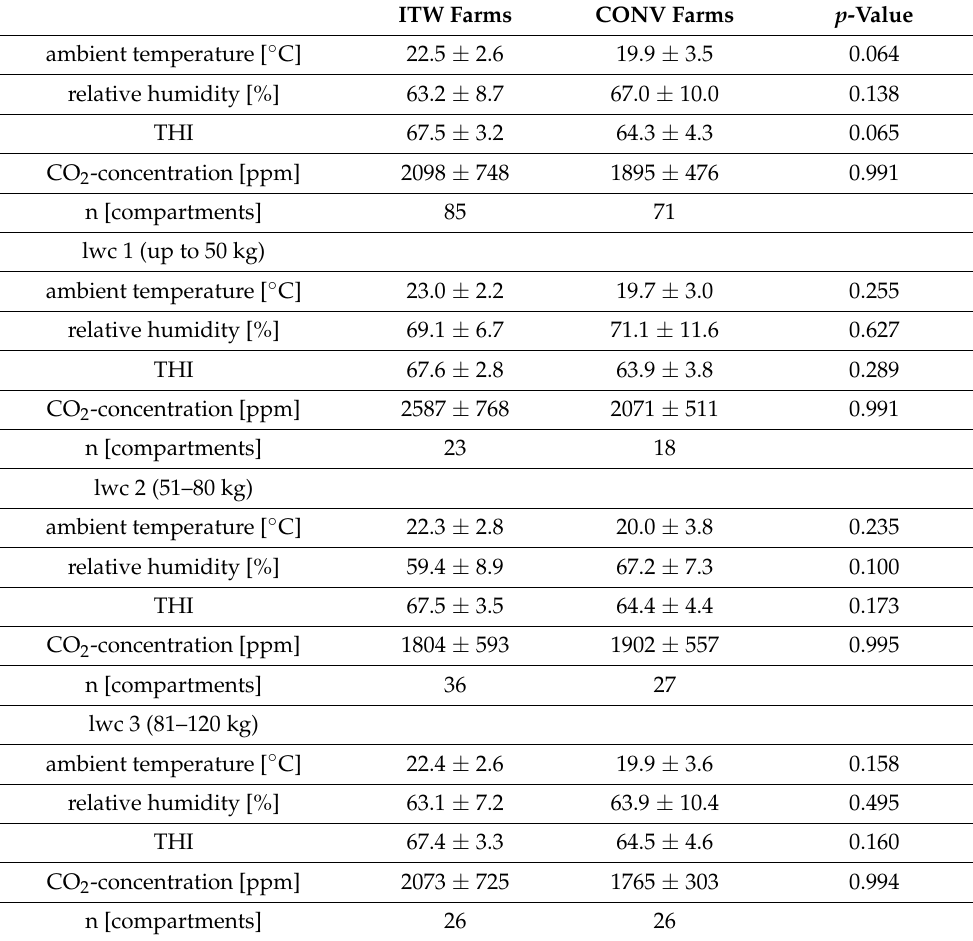
Table 5. Indoor climatic conditions in pig compartments on ITW and CONV farms. Data are presented as means ± standard deviation and statistically analysed using PROC GLIMMIX (SAS). ITW Farms CONV Farms p